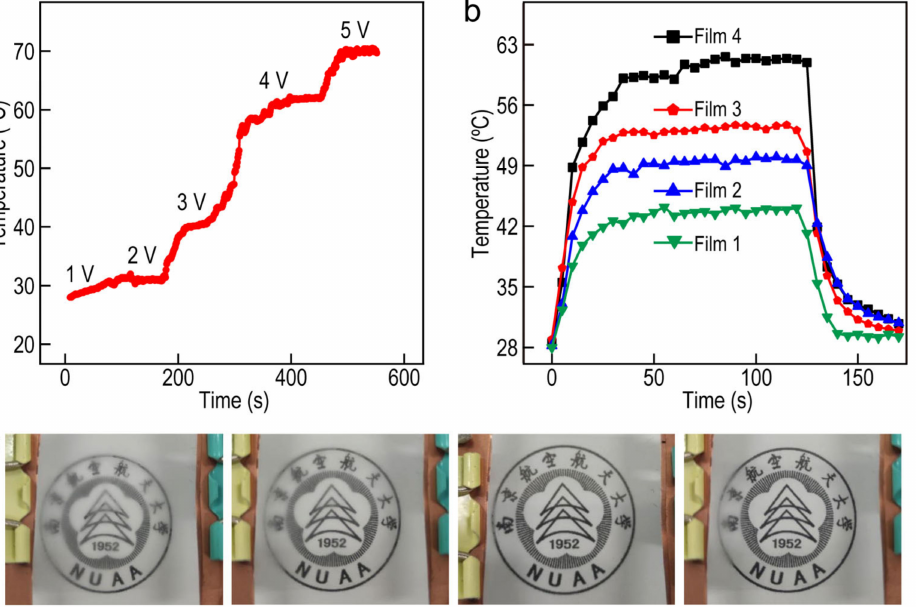
Figure 6. ( a ) The temperature evolution of the Ag NW/PMMA FTCFs with stepwise voltage increases from 1 to 5 V. ( b ) Temperature increase profiles of the Ag NW/PMMA FTCFs with different Ag NW concentrations. ( c ) Photographs of the defogging process at a voltage of 3 V using Ag NW/PMMA FTCFs at different time